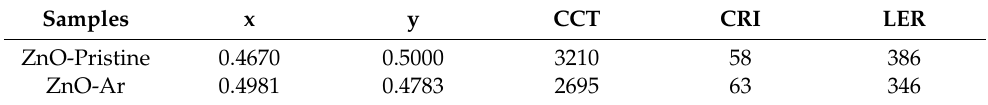
Table 1. The values of XY coordinates, correlated color temperature (CCT), color rendering index (CRI), and luminous efficacy of radiation (LER) for pristine ZnO and Ar